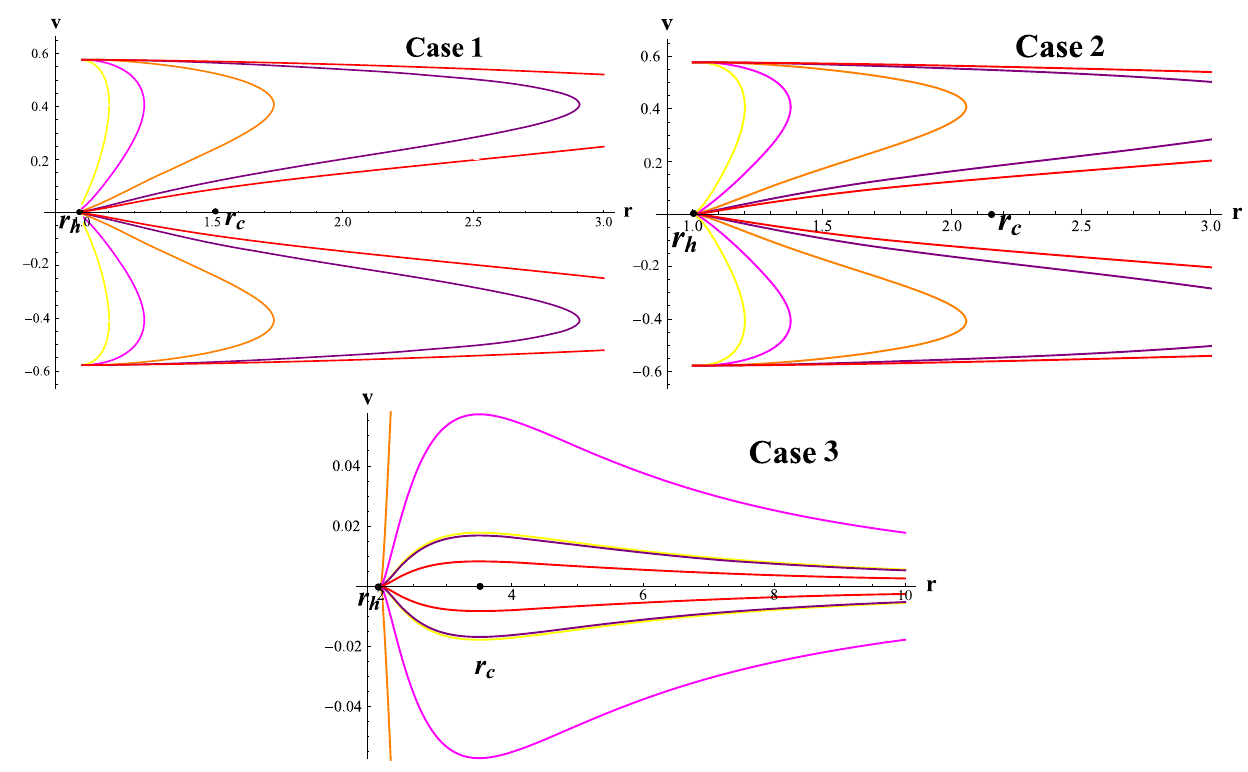
Figure 7 represents the contour plots for conformal BH (left panel), Schwarzschild–de Sitter BH (right panel) and Schwarzschild BH (bottom panel) with n c = 0 . 15, X = 5, α = 5 / 3. We have presented the behavior of matter by taking the sonic points r c ≈ 1 . 9855, v c ≈ 0 . 56218, H = H c (cid:10) 4 . 2876 for conformal BH, r c ≈ 3 . 7859, v c ≈ 0 . 44216, H = H c (cid:10) 2 . 1377 for Schwarzschild–de Sitter BH and r c ≈ 5 . 2865, v c ≈ 0 . 24211, H = H c (cid:10) 1 . 9374